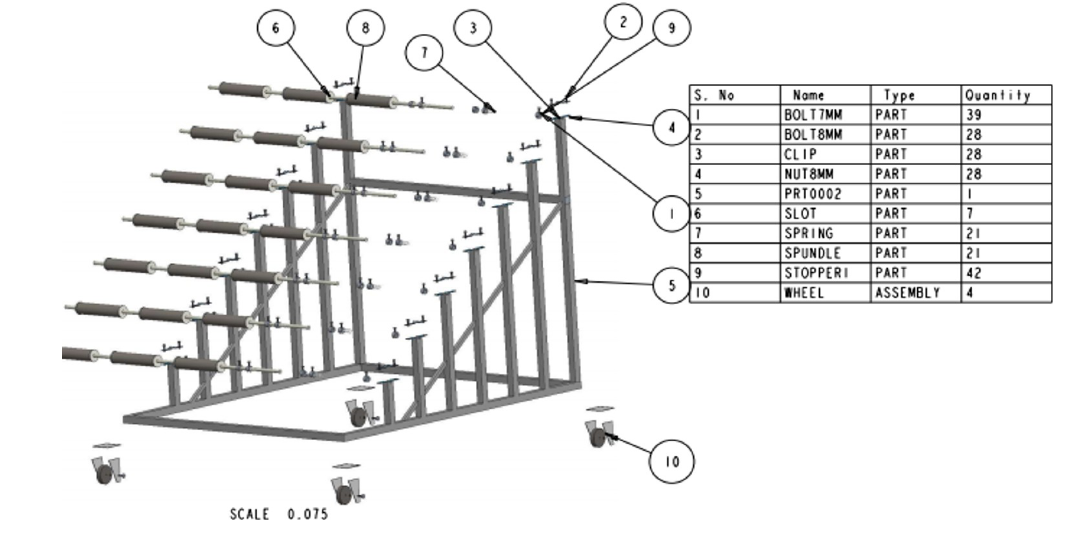
FIG.4 THREE DIMENSIONAL VIEW AND DIMENSIONS OF WARP CREEL